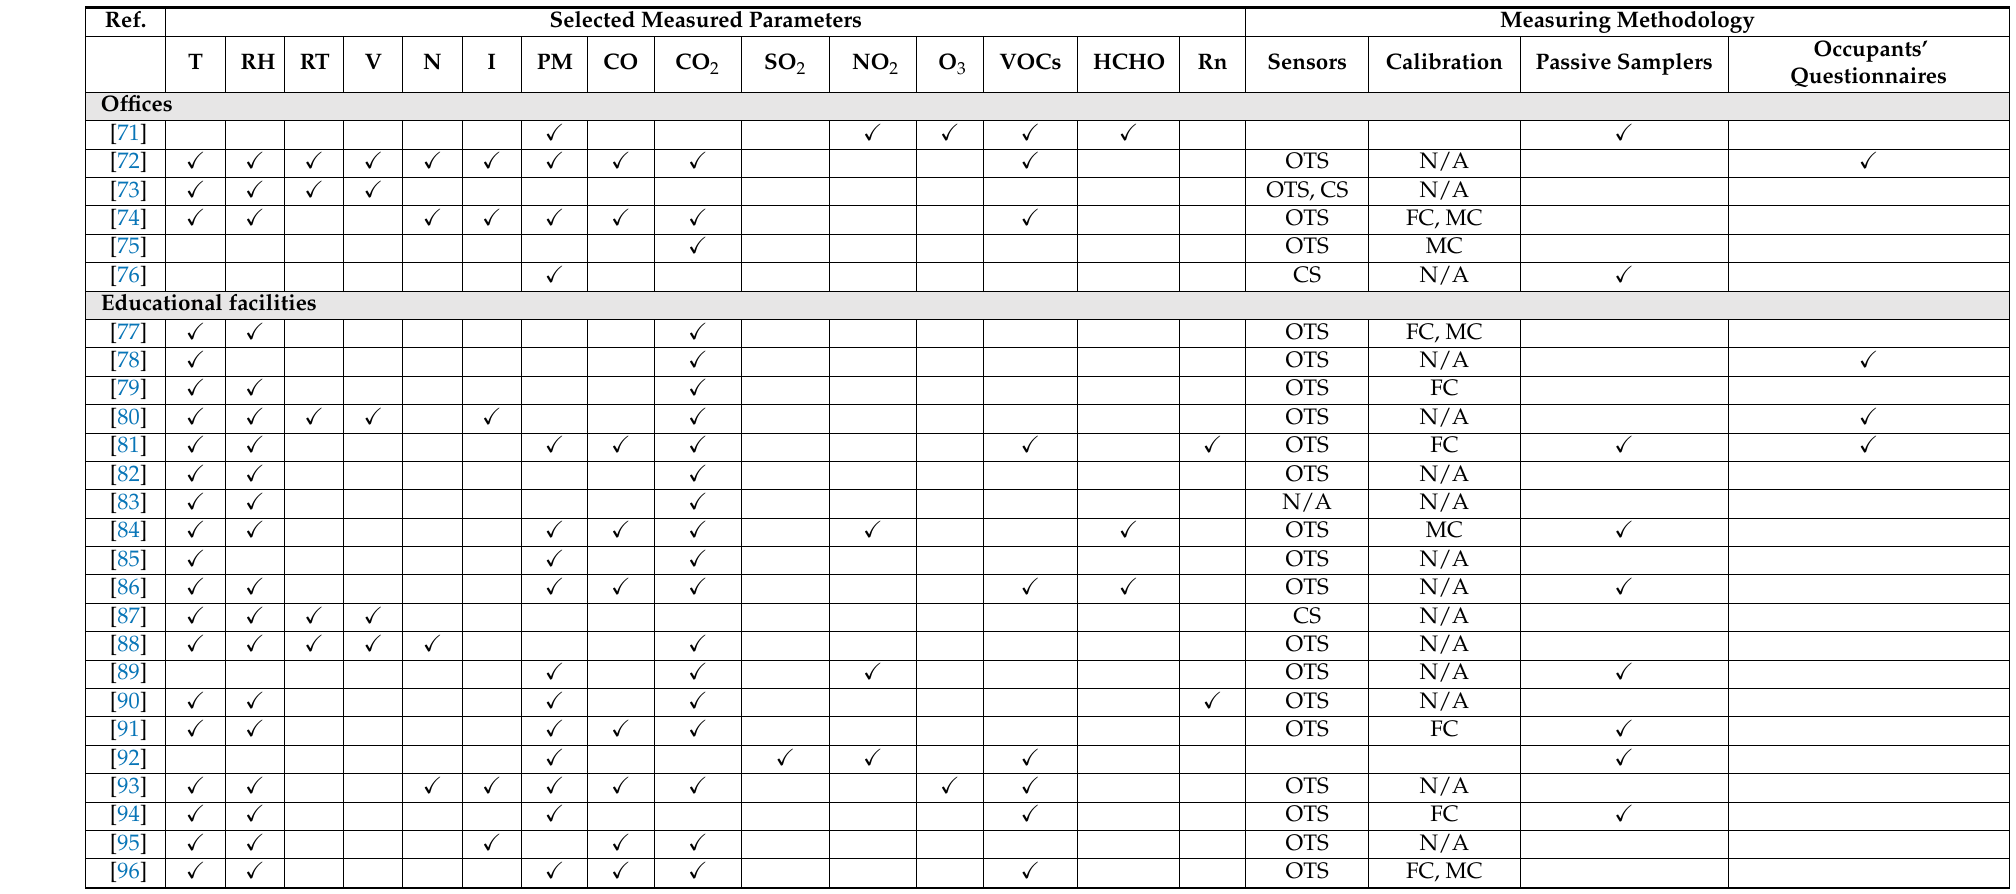
Table A2. Field measurement studies parameters and